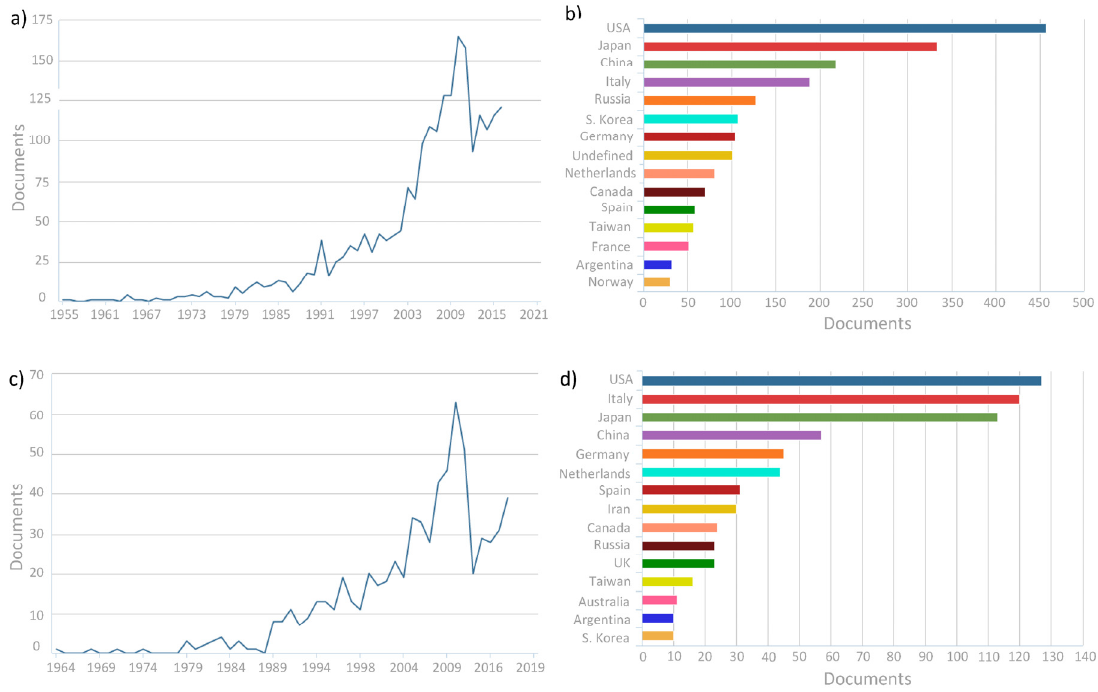
Figure 2. Citation analysis report by Scopus for keywords: palladium + membrane + hydrogen ( a , b ) and palladium + membrane reactor + hydrogen ( c , d ).